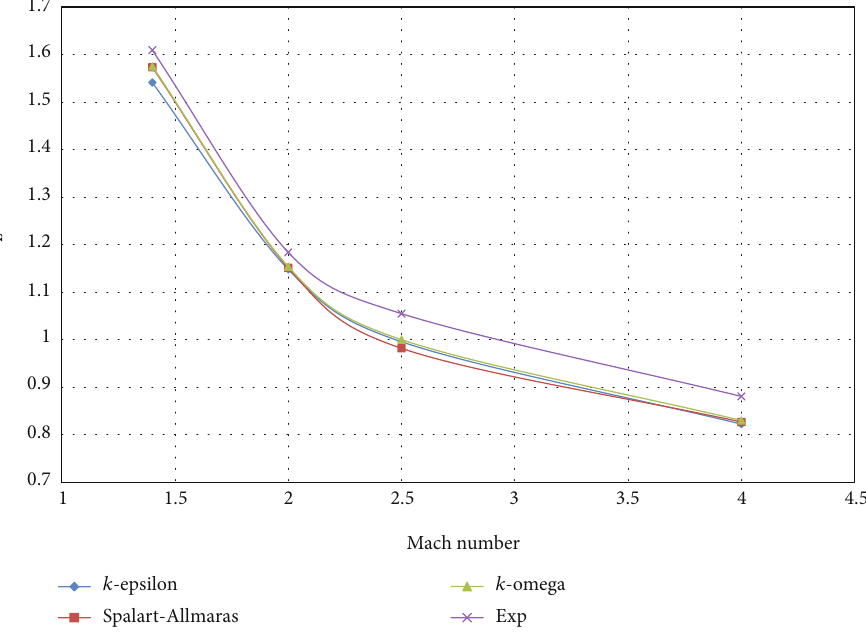
Figure 9: Lift coe ffi cient versus Mach number at 6 °